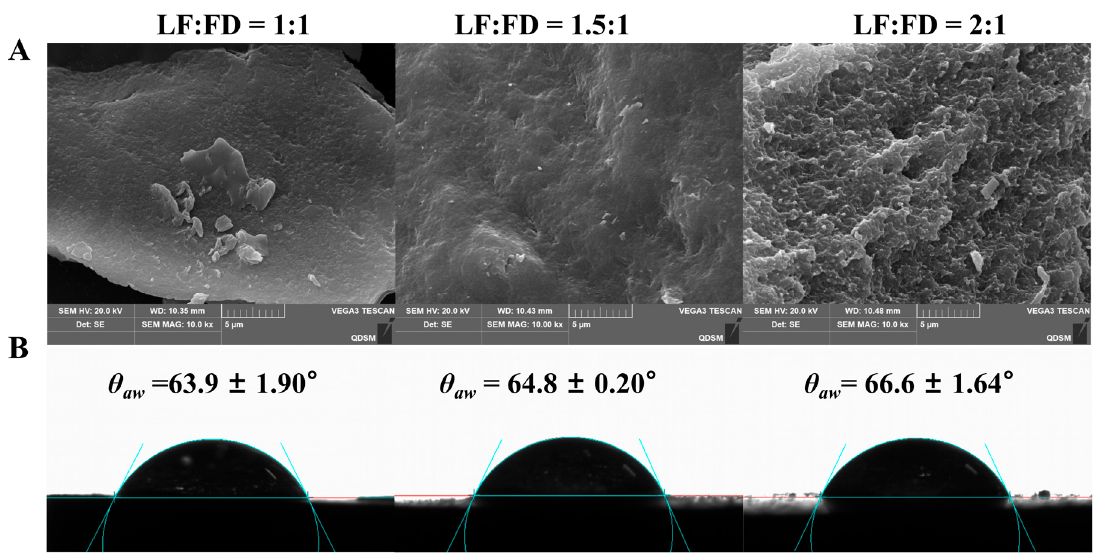
Figure 3. SEM micrographs ( A ) and static water-in-air contact angles ( B ) of the LF–FD complexes.